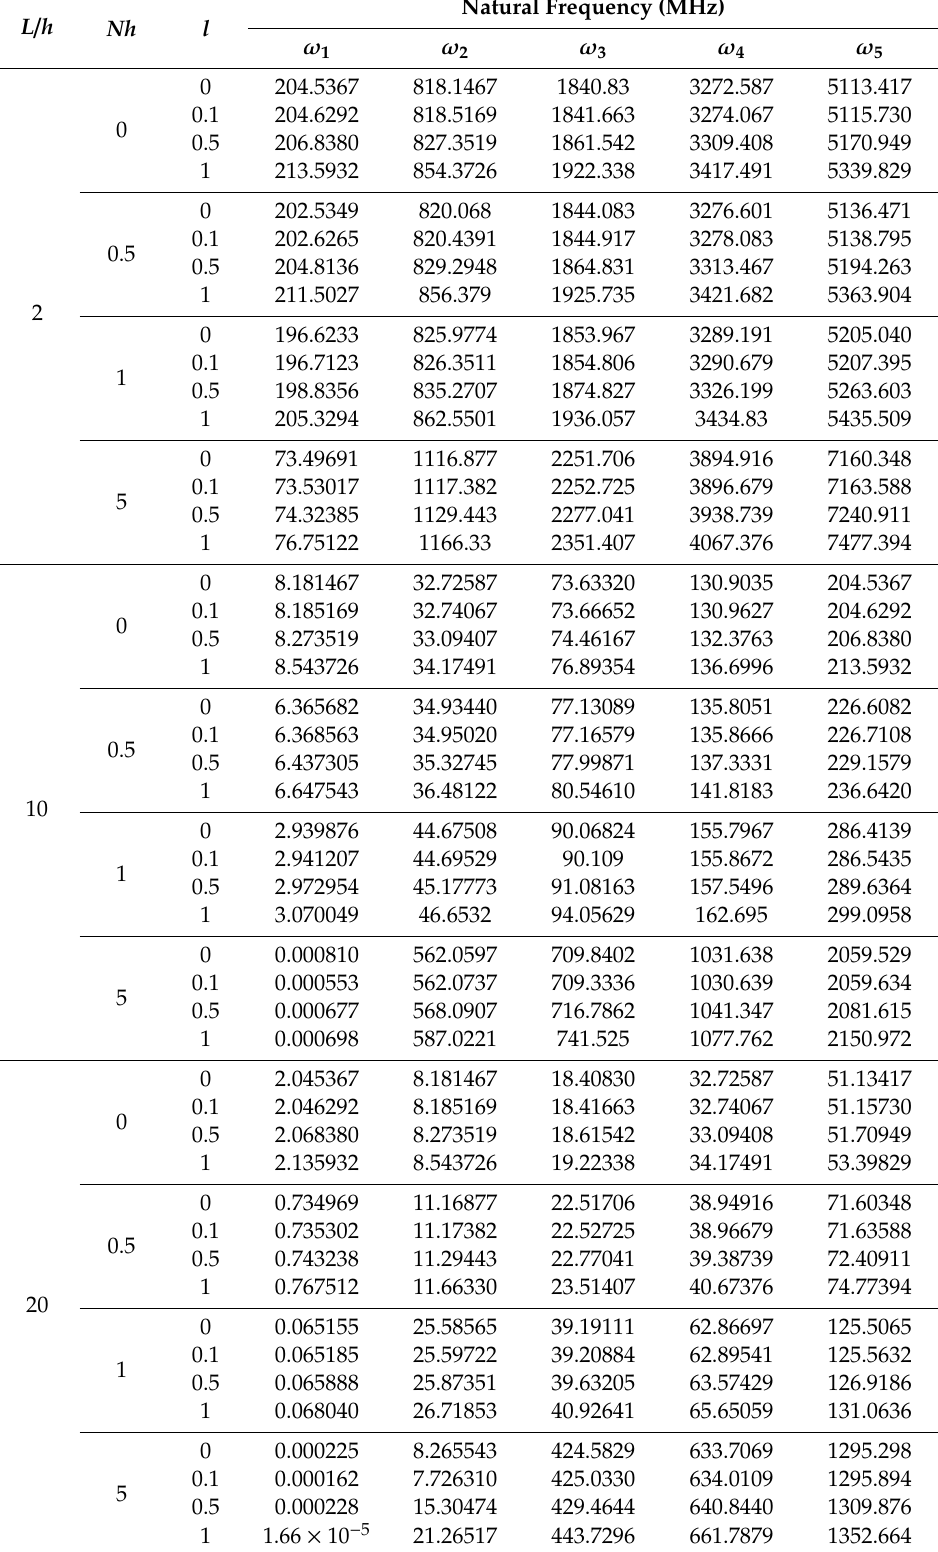
Table 3. Natural frequency of the S-S three-layer [90 ◦ ,0 ◦ ,90 ◦ ] Euler–Bernoulli